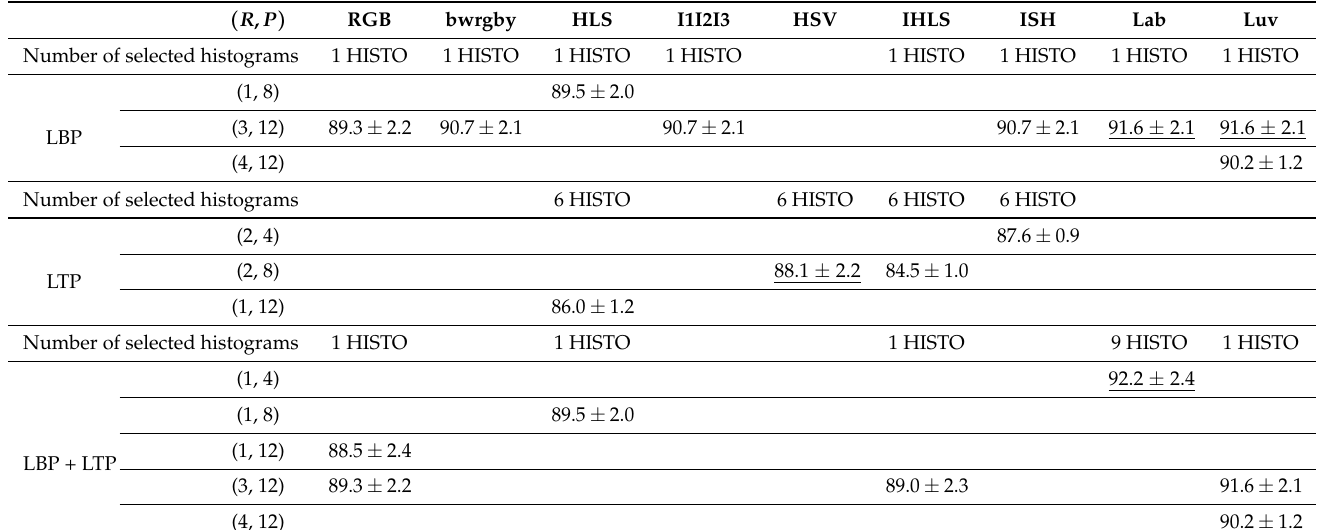
Table 5. The best results obtained for Cloud-ImVN 1.0 dataset while using histogram selection method. The best results for each color space, each feature, and the selected parameters ( R , P )